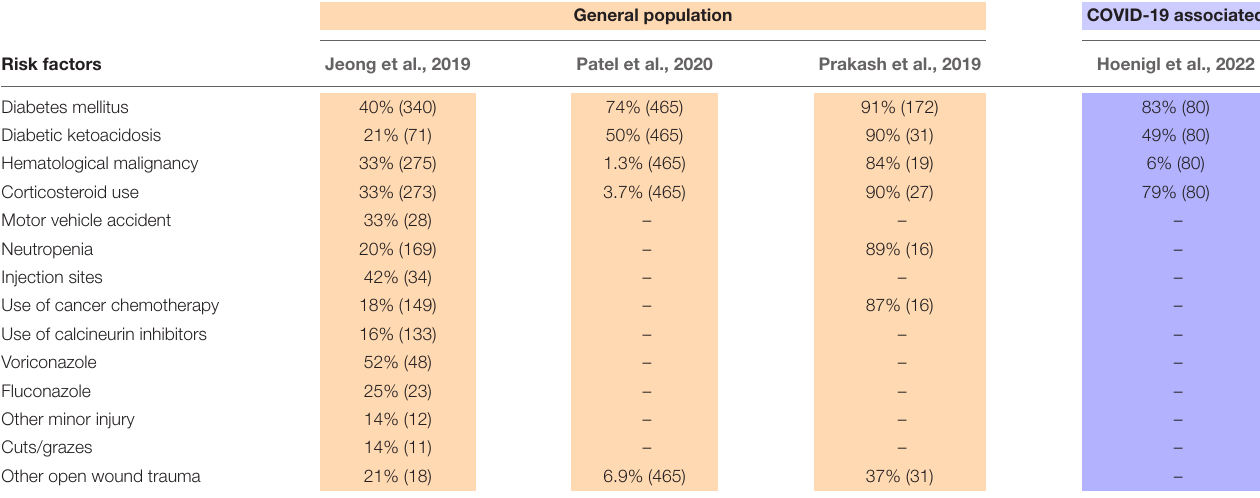
TABLE 1 | Comparison of underlying conditions and predisposing factors for the development of